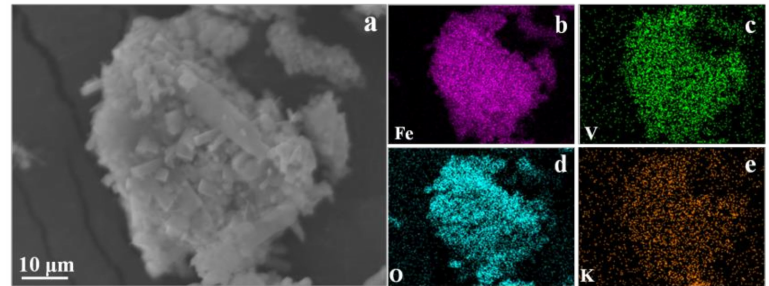
Figure 7. ( a ) SEM image of leaching slag (optimal conditions); EDS elemental distribution: ( b ) Fe; ( c ) V; ( d ) O; ( e ) K.